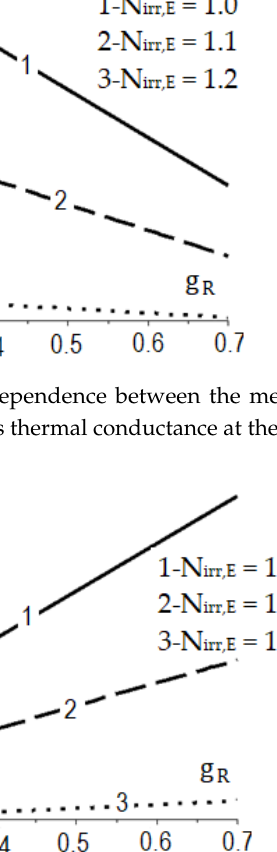
Figure 12. Dependence between the mean log temperature difference at the hot side and the dimen- sionless thermal conductance at the cold side, ∆ T 0 = f ( g R ).